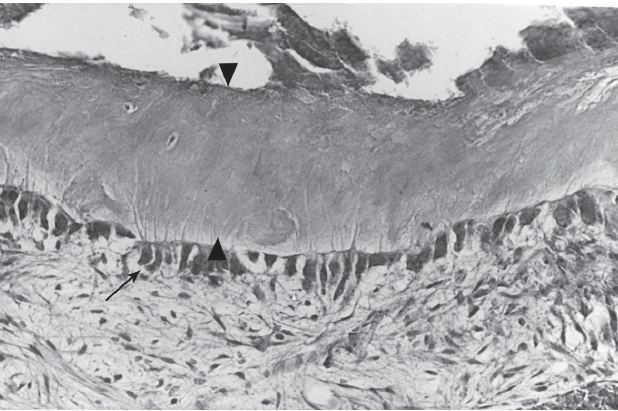
Fig. 3 - (group I; 30th day) - Moderate deposition of hard tissue subjacent to the pulp wound. Presence of odontoblast-like cells in monolayer. Hematoxylin-eosin, original magnification